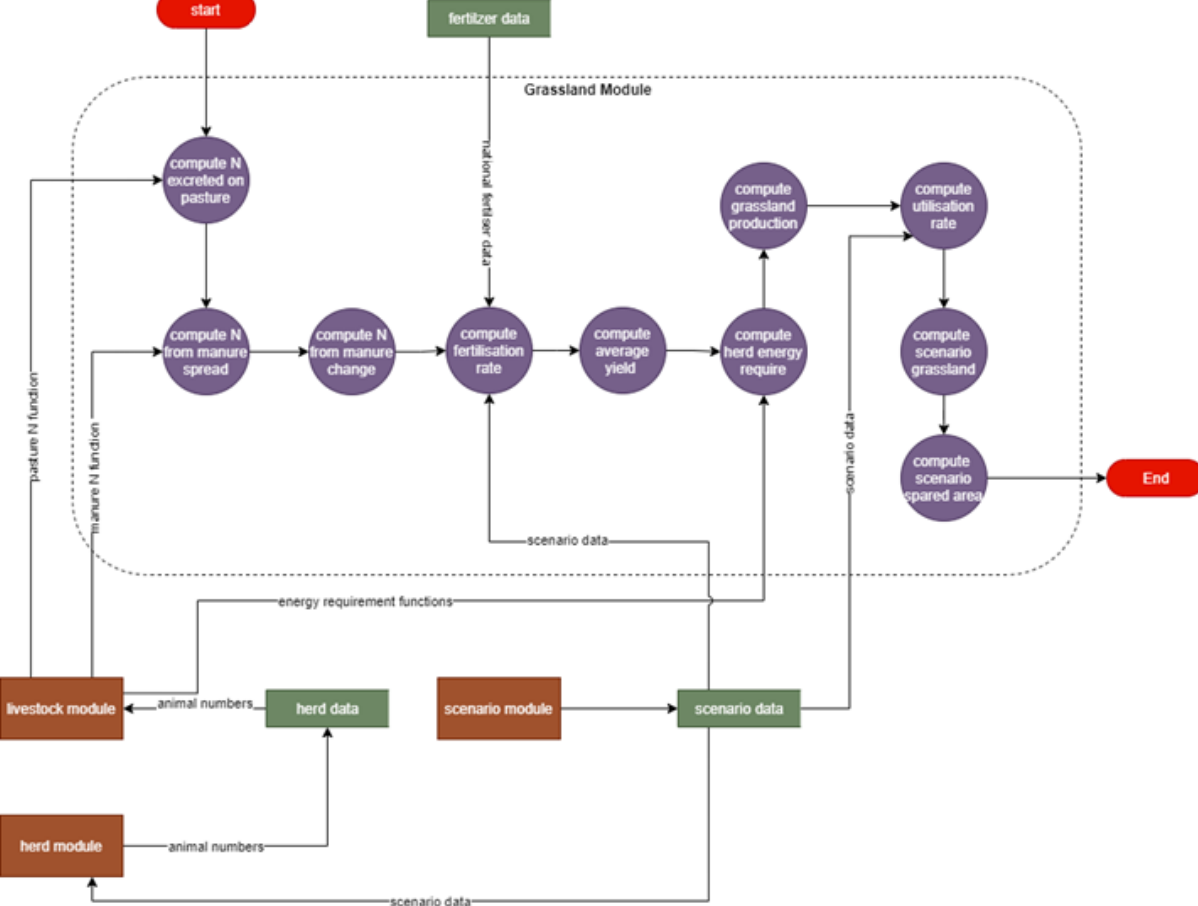
Figure 3. Data flow and processing through the grassland module. Arrows represent data flow. Modules are represented by brown rectangles, processes are represented by purple circles, and open-ended green rectangles represent data